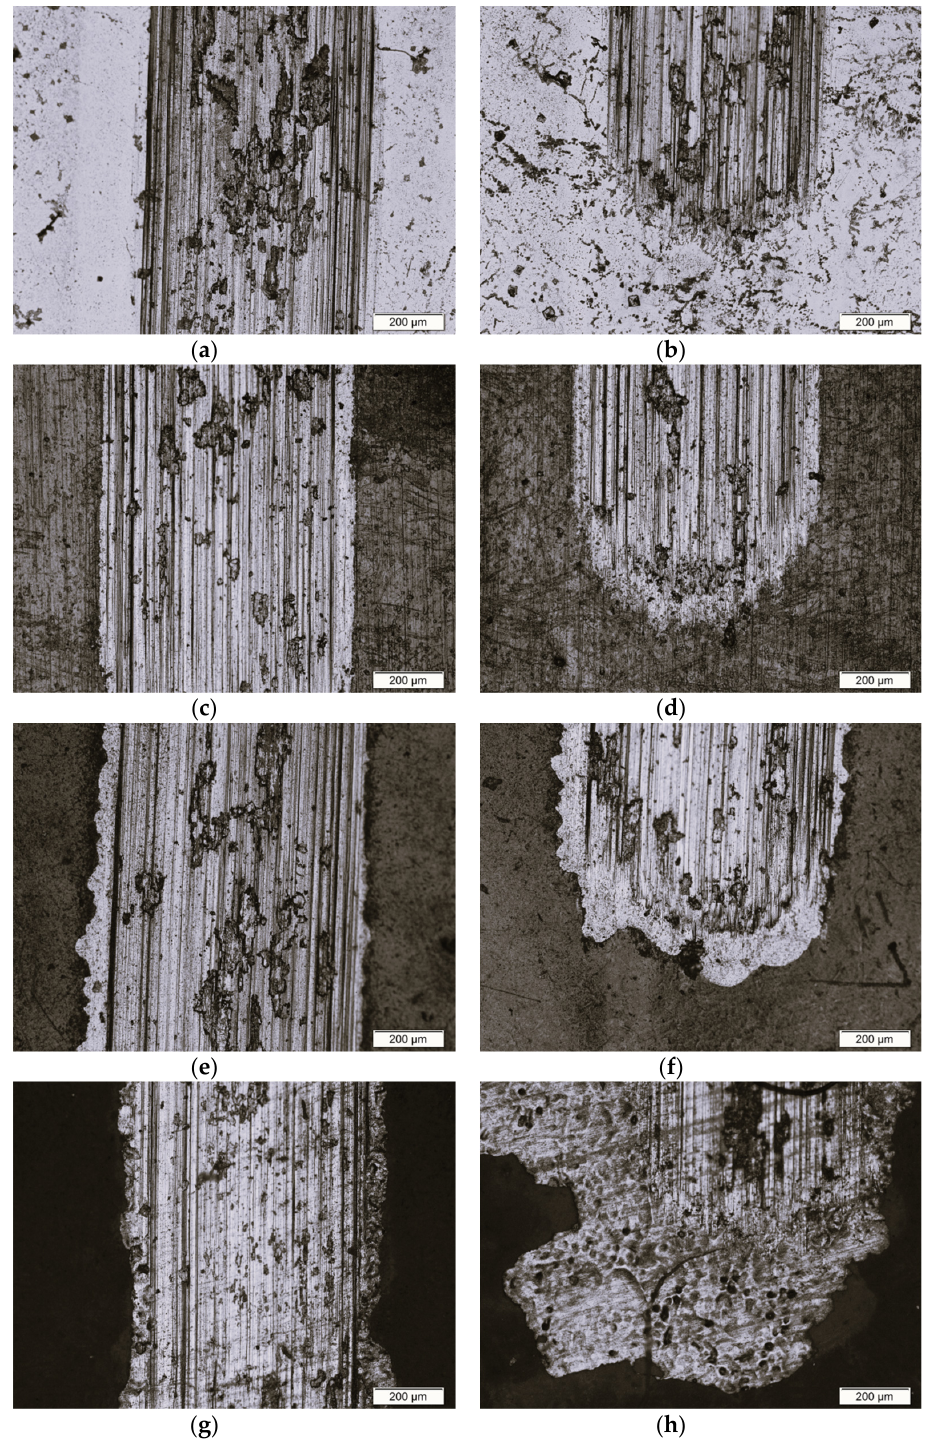
Figure 11. Microscopic image of wear track after the biotribological test in the ball-on-flat combination system for: ( a , b ) Ti–13Zr–13Nb alloy; ( c , d ) 1G ONT layer; ( e , f ) 2G ONT layer; ( g , h ) 3G ONT layer.